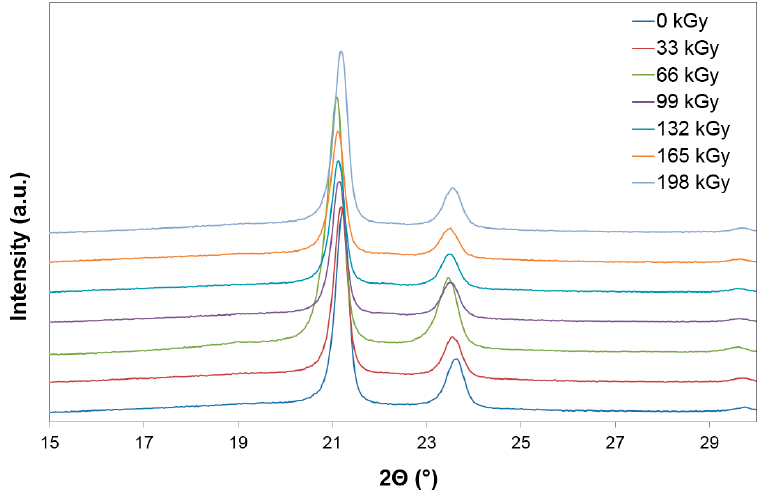
Figure 7. X-ray diffraction—Commodity polymers (HDPE).